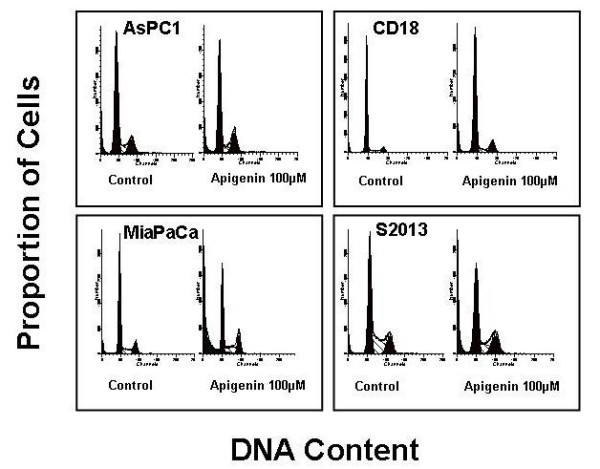
Effects of apigenin on the proportion of cells in different phases of the cell cycle. Apigenin caused G2/M arrest in all four human pancreatic cancer cell lines studied. Similar results were seen in four different experiments.